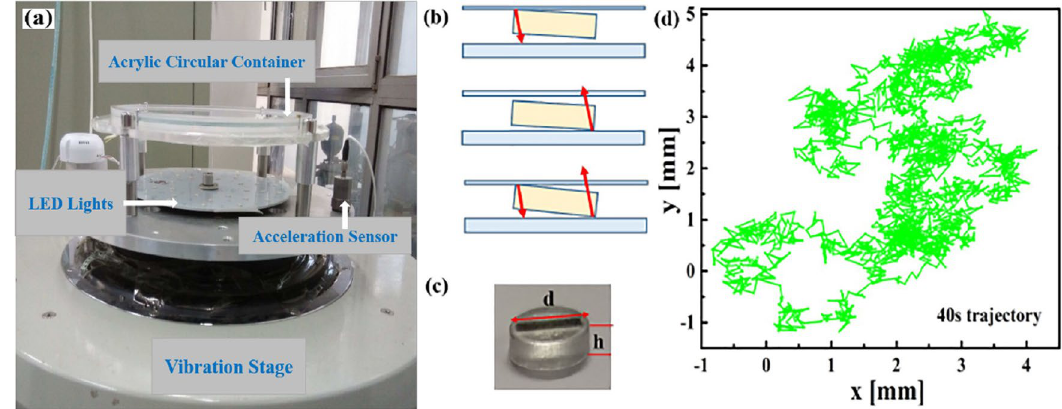
280 mm and inner wall Figure 1. ( a ) A disk is confined in a translucent acrylic container with diameter D = 4.5 mm mounted on the vibration stage. ( b ) The disk can collide with top, bottom or both separation H = 10 mm, thickness h 3.5 mm and mass M 2.0 g and is made with the walls. ( c ) The disk has diameter d = = = cartridge plastic material DurusWhite using a 3D printing system (Connex350). The black line is printed inside the disk for tracking the rotational motion in image processing and does not affect the mass distribution. ( d ) A 50 Hz and A 6.0 ( f 0.6 typical 40 s trajectory of the translational motion at Ŵ = = =